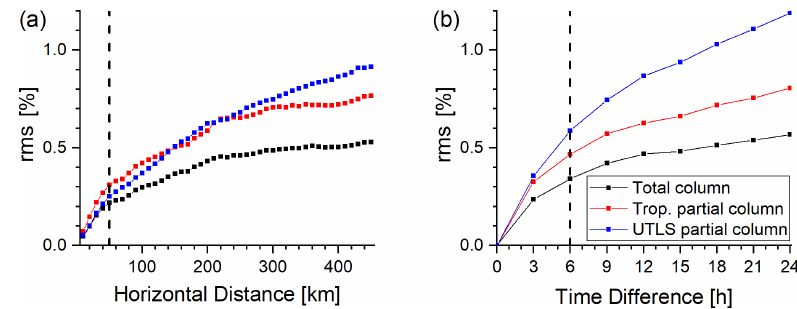
– calculated ac- C , dl